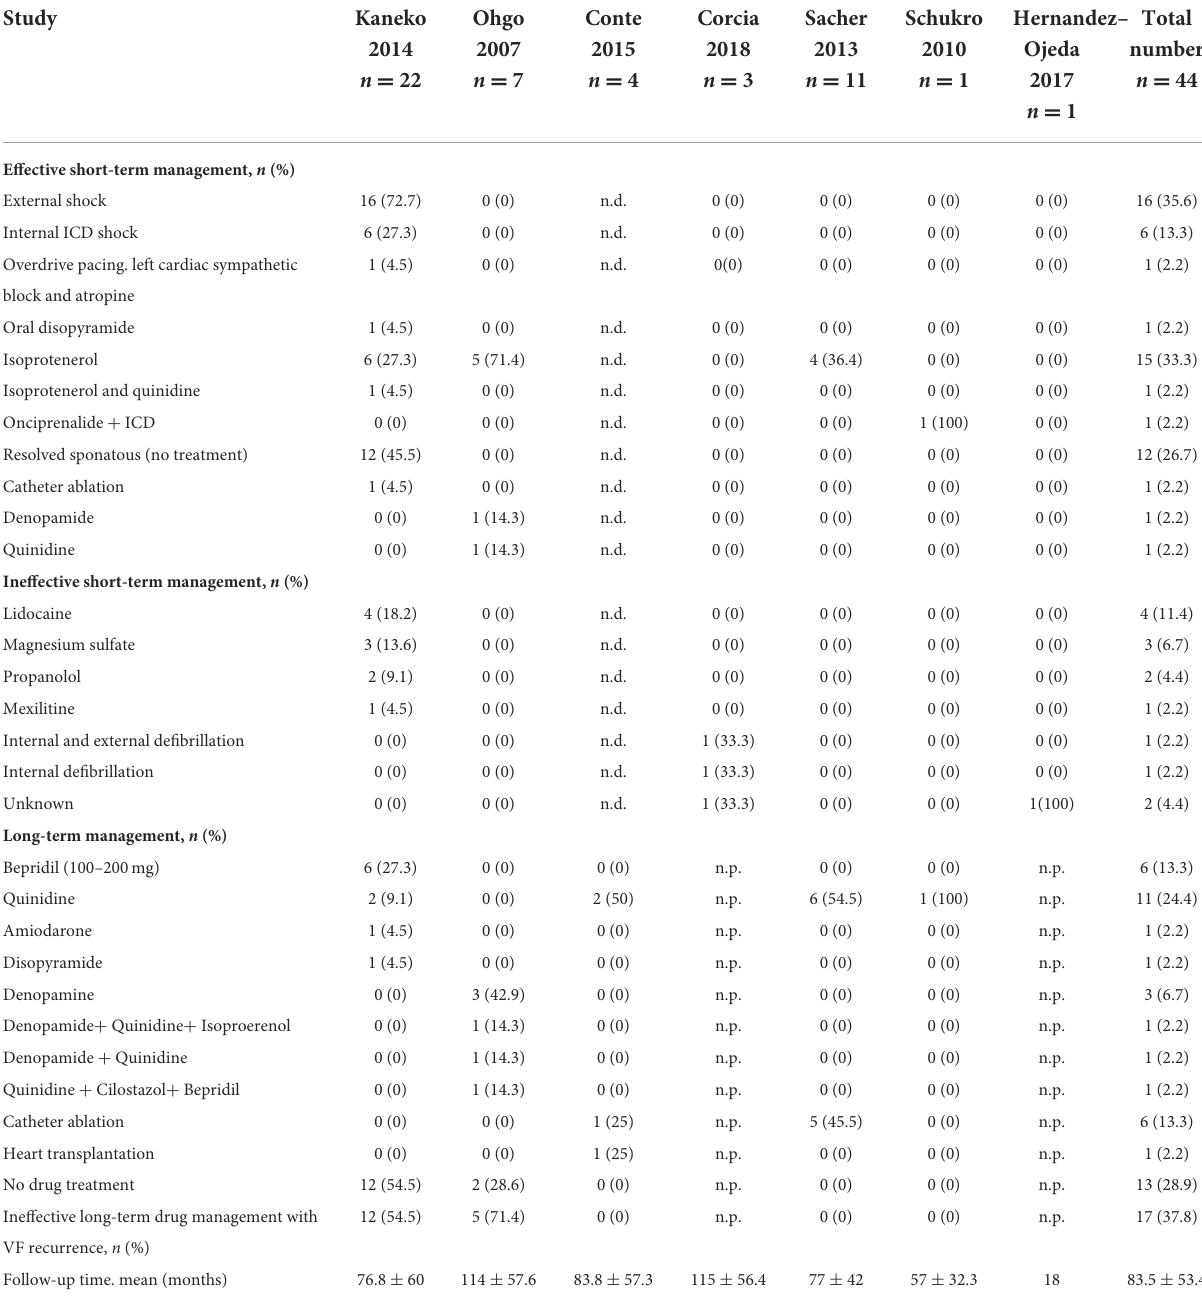
TABLE 2 Management of BrS suffering from